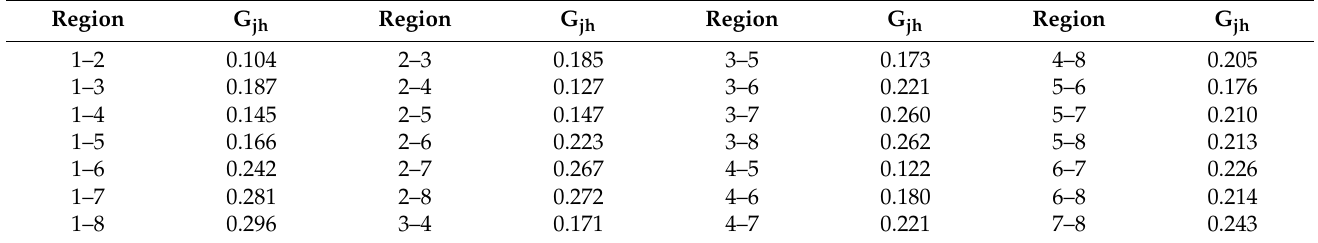
Table 6. Spatial differences in EWP among the eight economic regions from 2006 to